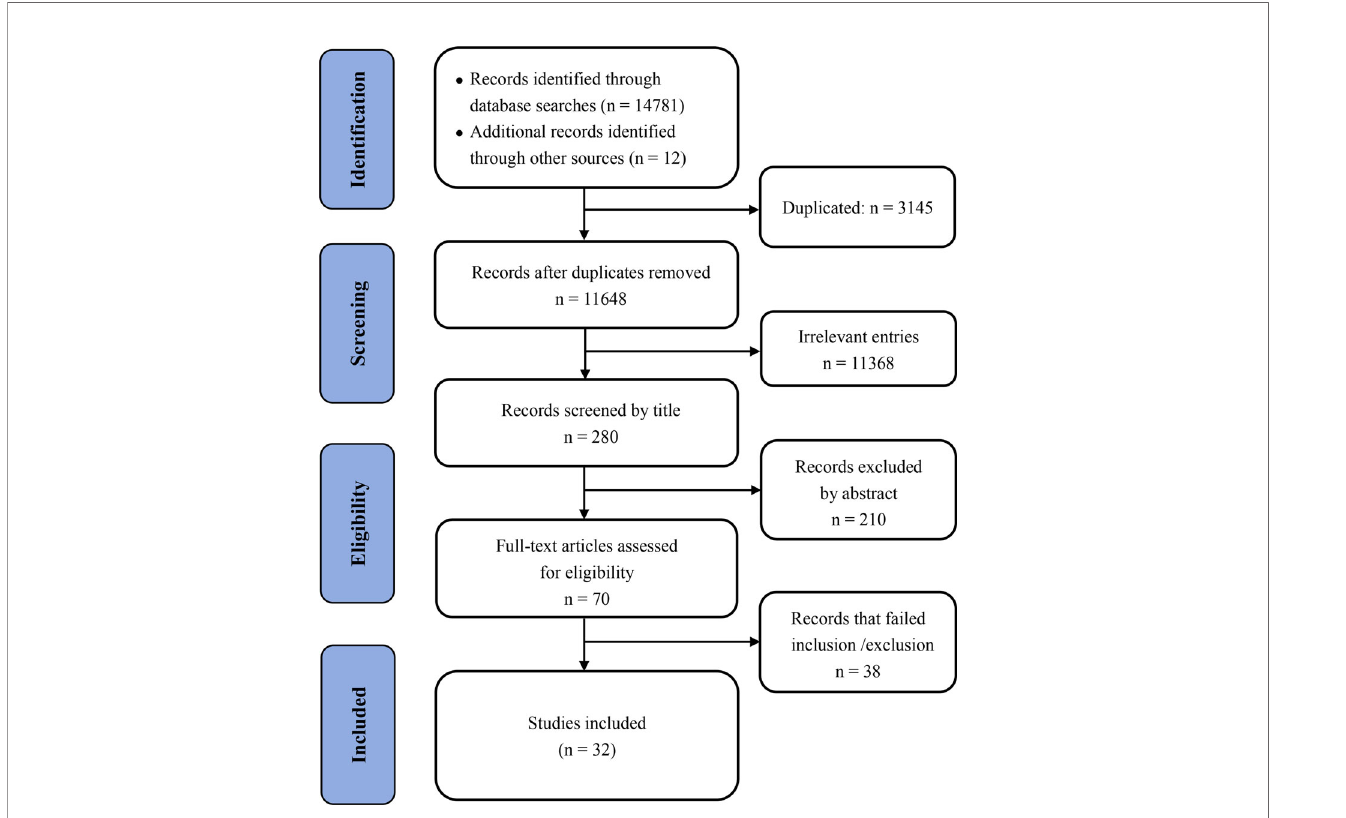
FIGURE 1 | Flow diagram of article